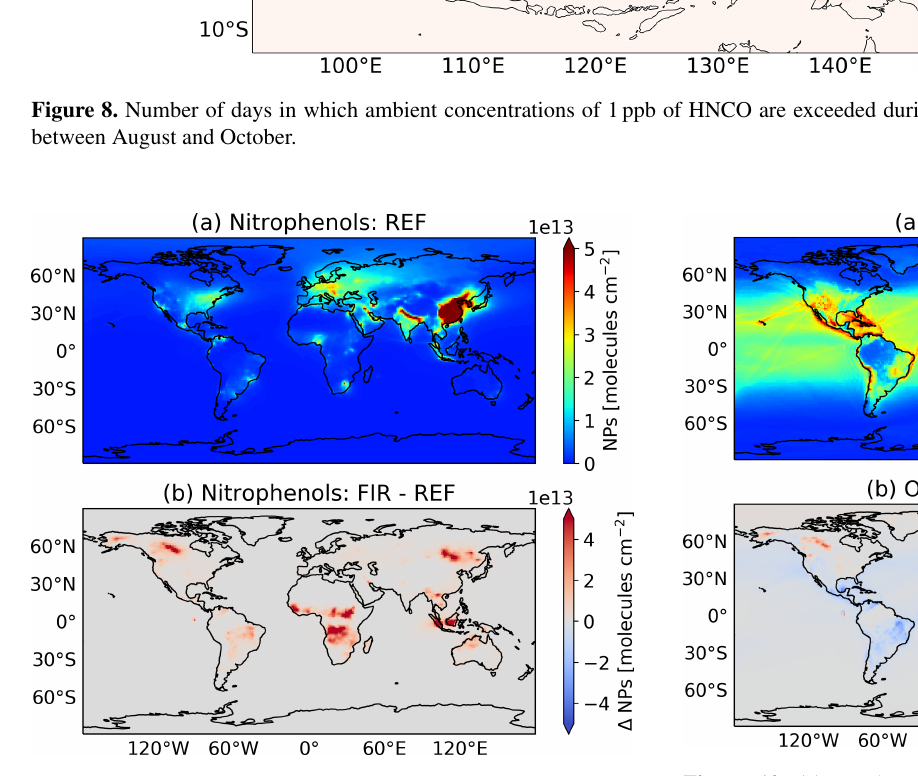
Figure 9. (a) Yearly mean tropospheric nitrophenol (NPs) column without biomass burning VOC emissions. (b) Changes in the yearly mean tropospheric nitrophenol (NPs) due to VOC biomass burning.